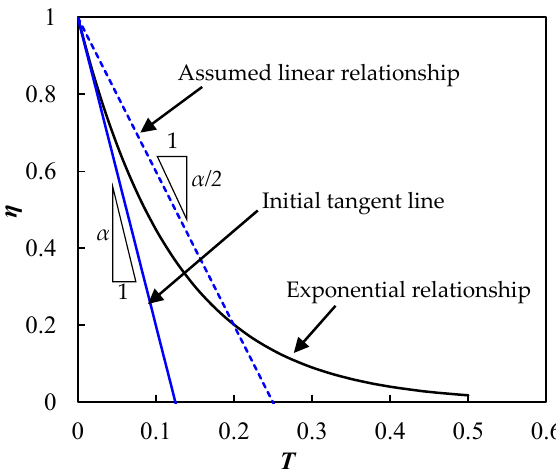
Figure 5. Exponential and assumed linear variation of η with T .